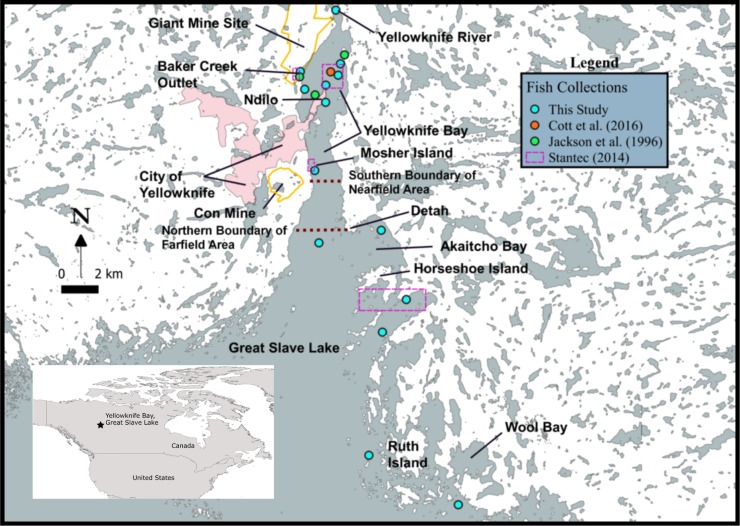
Map of the study area on Great Slave Lake.Inset map shows the location of Great Slave Lake and the Northwest Territories within Canada. Boundaries between the nearfield and farfield areas in Yellowknife Bay are identified as well as approximate fish collection sites for this study and literature data. Locations are presented for the Giant and Con mine sites and communities (Yellowknife, Ndilo and Detah) within the study area.